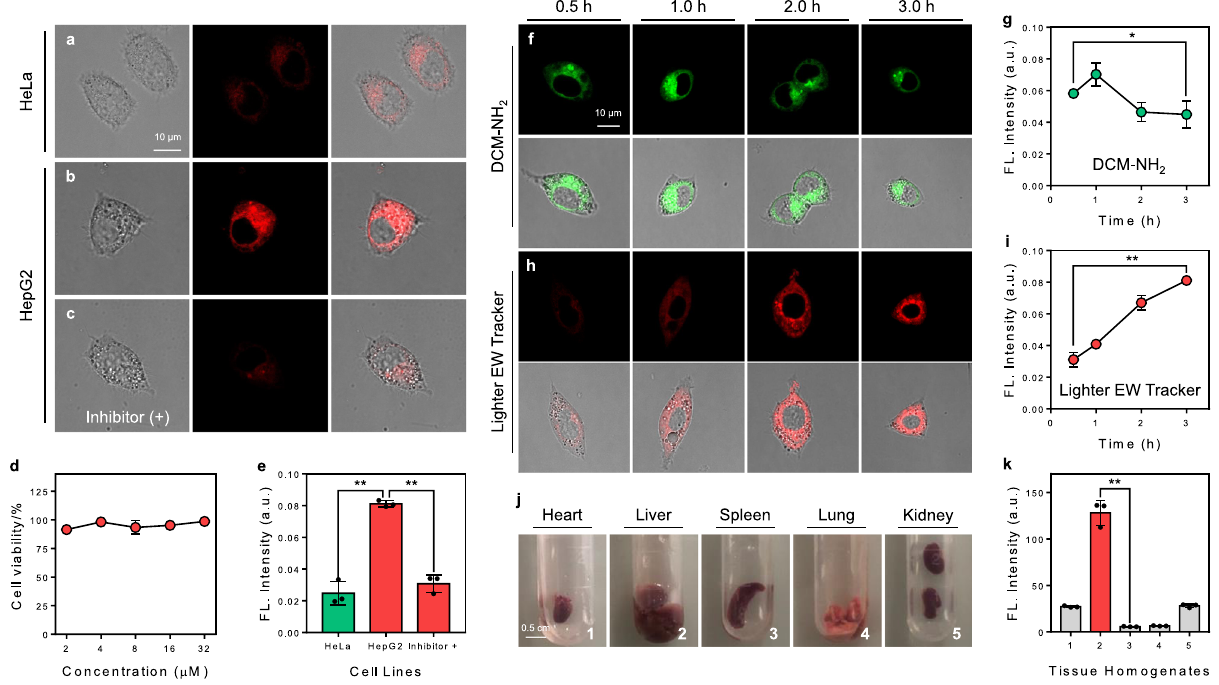
Fig. 6 Lighter EW Tracker enables real-time and light-up sensing of endogenous NATs in living cells and tissue homogenates. a – c NIR fl uorescence imaging ( λ ex = 488 nm, λ em = 700 ± 20 nm) of HeLa cells ( a ) and HepG2 cells incubated with Lighter EW Tracker (DCM-IN-NH 2 , 10 μ M, incubated for 2 h) and either untreated ( b ) or treated with ( c ) quercetin (an inhibitor of NATs, 1 mM). Each experiment of a – c was repeated independently 3 times with similar results. d Remarkable biocompatibility of Lighter EW Tracker. Data with error bars are expressed as mean ± s.d., n = 3 biologically independent cells. Source data are provided as a Source Data fi le. e Relative NIR fl uorescence intensity in cell imaging experiments of a – c , p = 0.0032 (between HeLa and HepG2 group), p = 0.0024 (between HepG2 and Inhibitor group). Data with error bars are expressed as mean ± s.d., n = 3 biologically independent cells. Source data are provided as a Source Data fi le. f – i Time-dependent NIR imaging and relative NIR fl uorescence intensity of HepG2 cells incubated